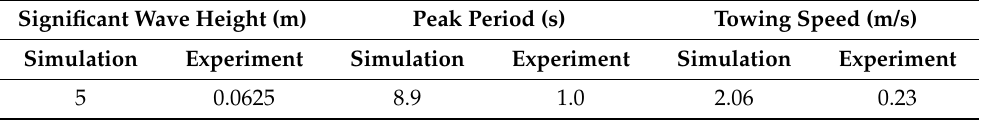
Table 3. Load case for verification of numerical